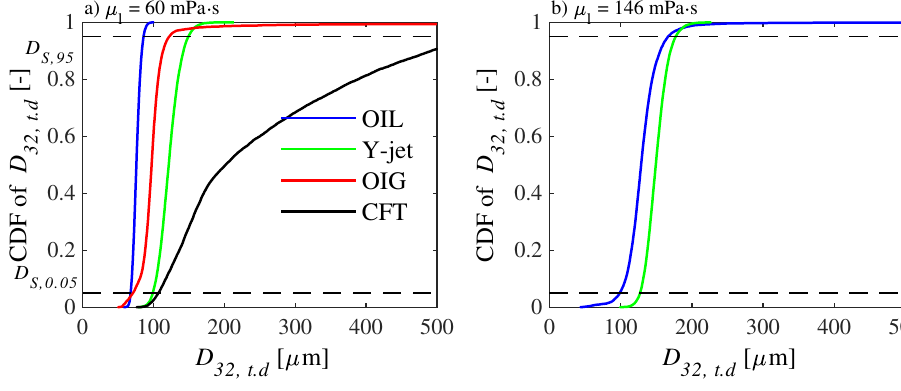
Figure 8. CDF of time-dependent drop sizes for spraying at GLR = 2.5%. Table 6. Parameters of the spray drop size distribution at GLR =